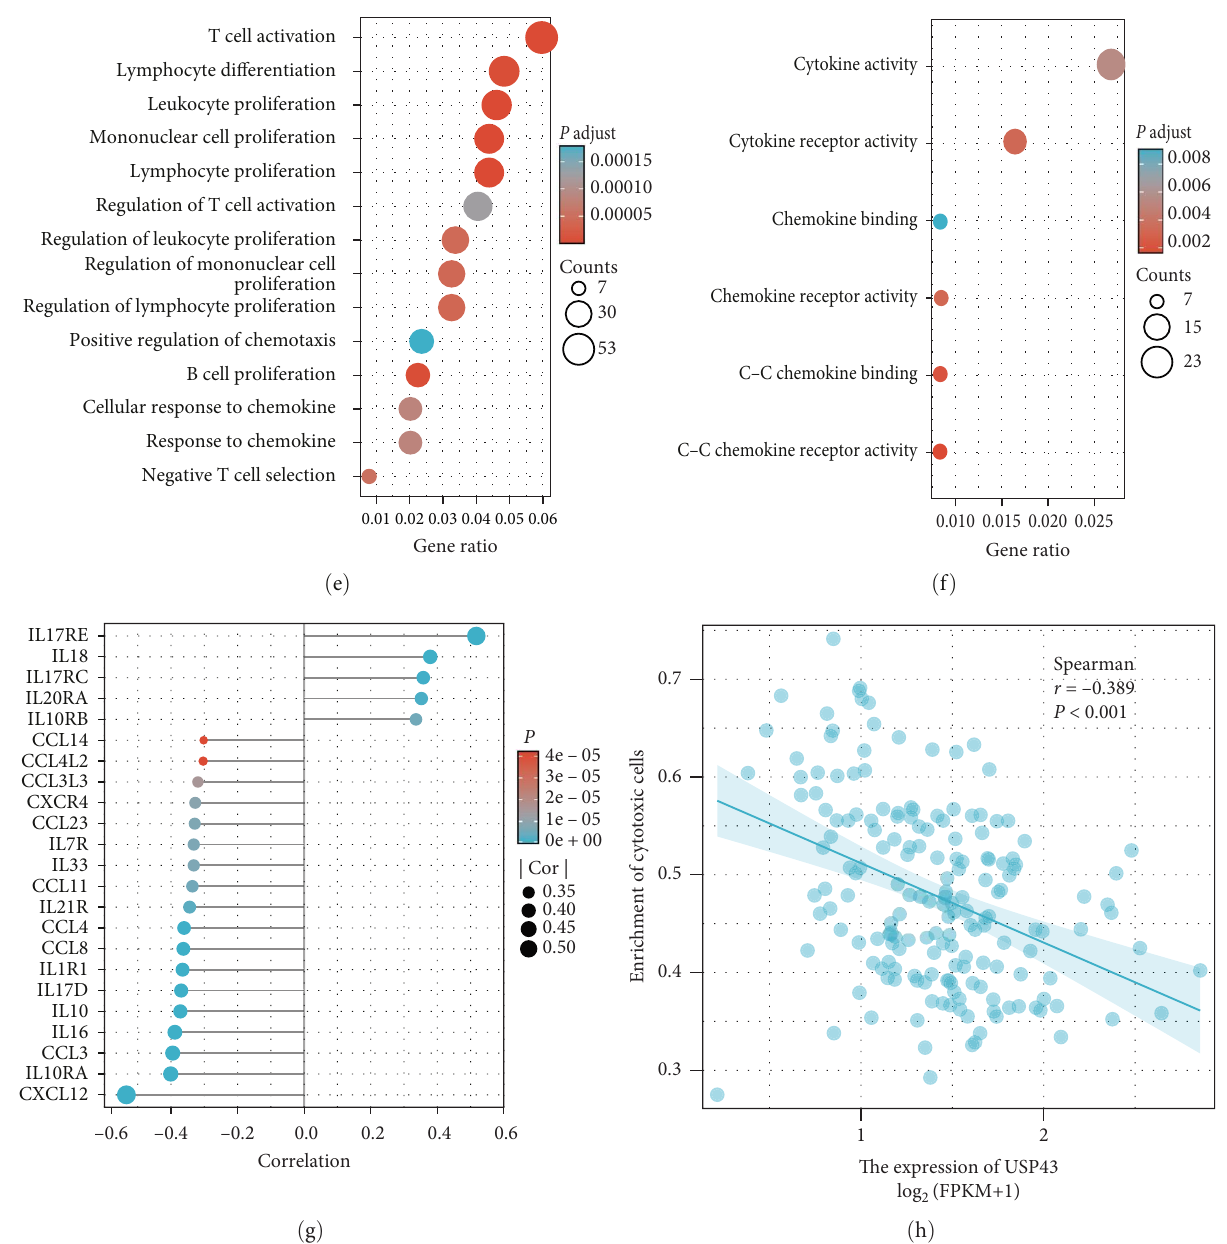
F IGURE 4: USP43 is associated with T cell activation and inhibits CD8 + T cell activation in PDAC based on TCGA database: (a) volcano plot of related genes differentially expressed in PDAC and normal pancreatic samples; (b) KEGG enrichment analysis was taken to fi nd associated pathway or biology behavior; (c) KEGG enrichment analysis of the relationship between chemokine signaling pathway and USP43 expres- sion; (d) KEGG enrichment analysis of the relationship between cytokine – cytokine receptor activity and USP43 expression; (e) GO enrich- ment analysis was taken and we observed that high USP43 expression related to many immunological biological processes; (f) the molecular function of USP43 associated with cytokine – cytokine receptor activity; (g) the correlation between USP43 and chemokines; (h) the correla- tion between USP43 and CTLs